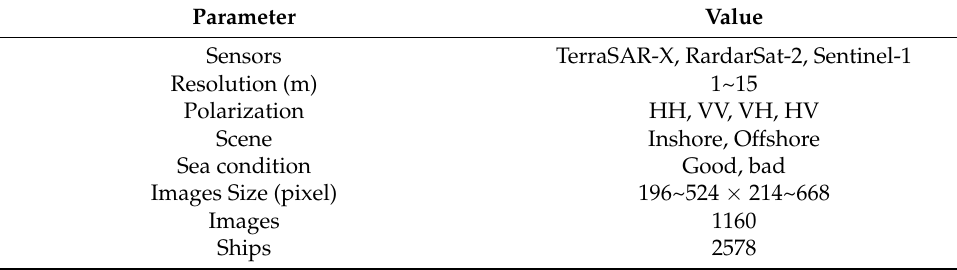
Table 1. The SSDD